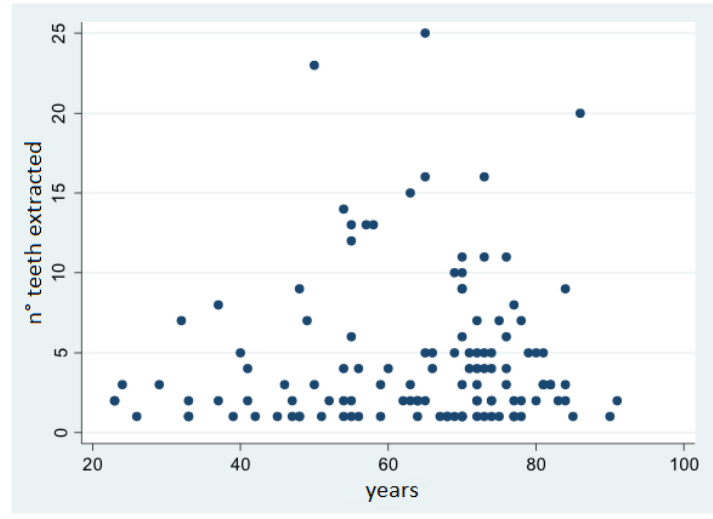
Figure 1. Correlation between age and number of teeth extracted.